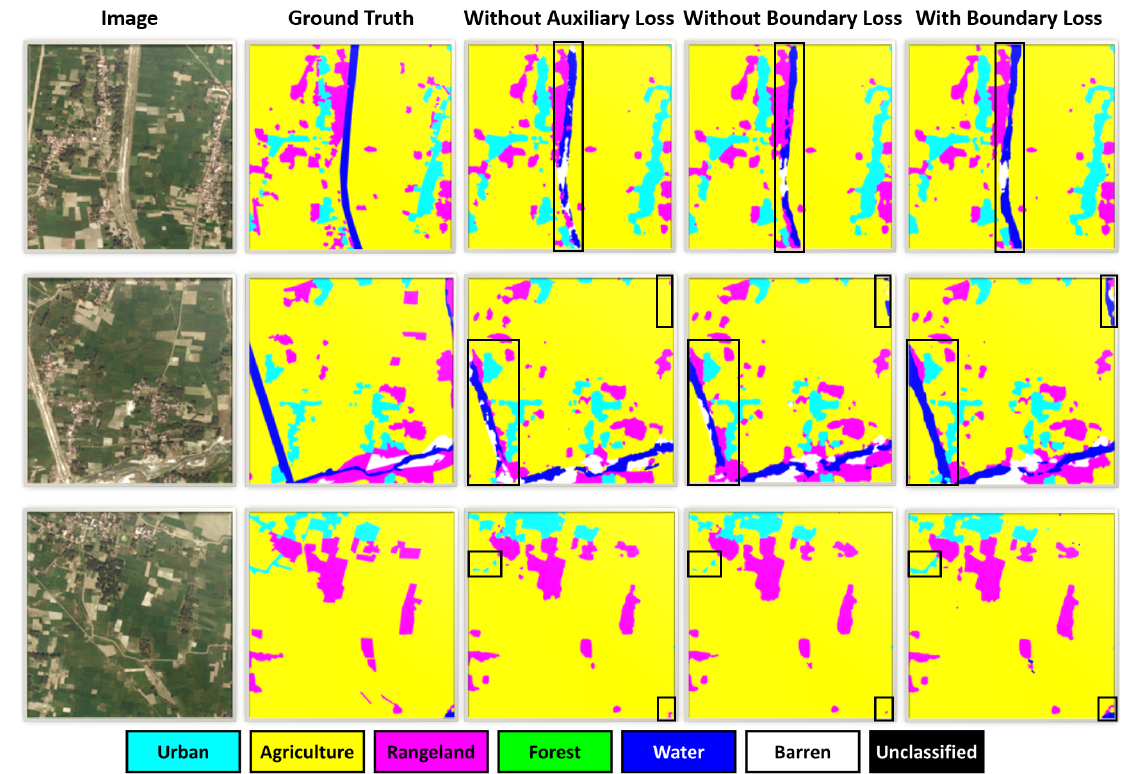
Figure 13. Comparison of the masks predicted by MKANets without any auxiliary loss, without auxiliary boundary loss, and with both types of auxiliary losses.